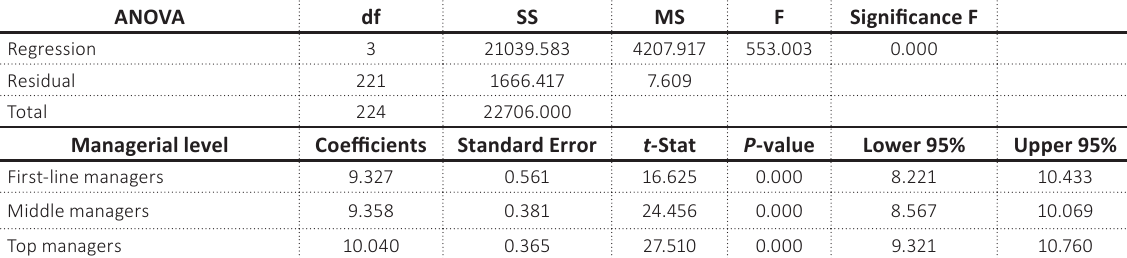
Table 2. Dispersion analysis of the equation (2) parameters